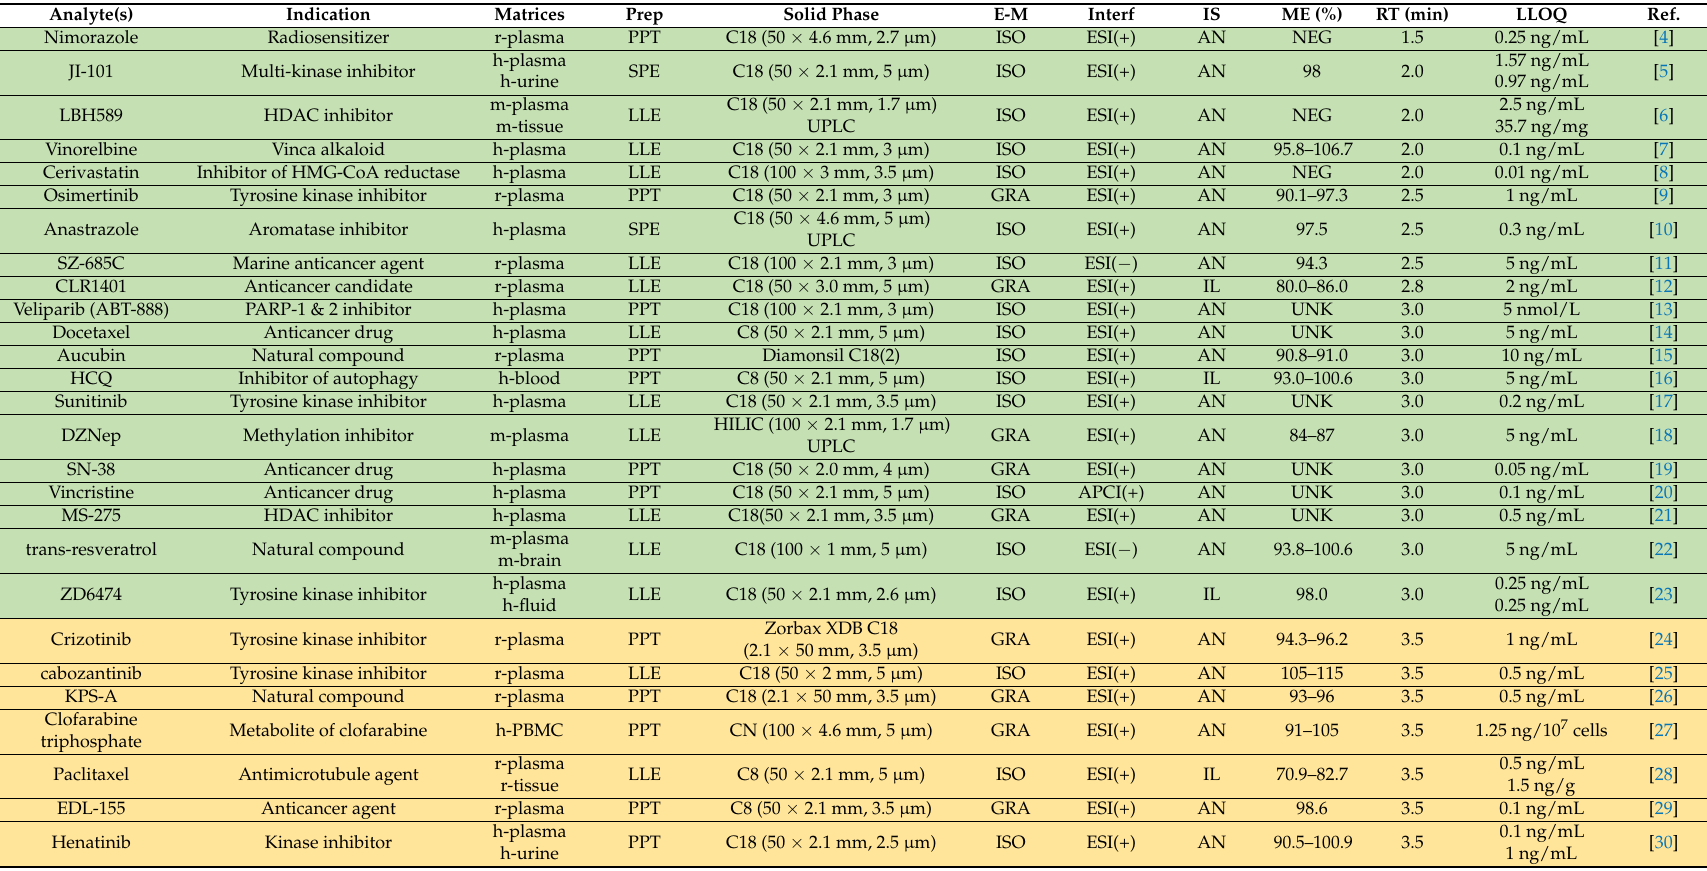
Table 1. LC-MS/MS methods for determination of one